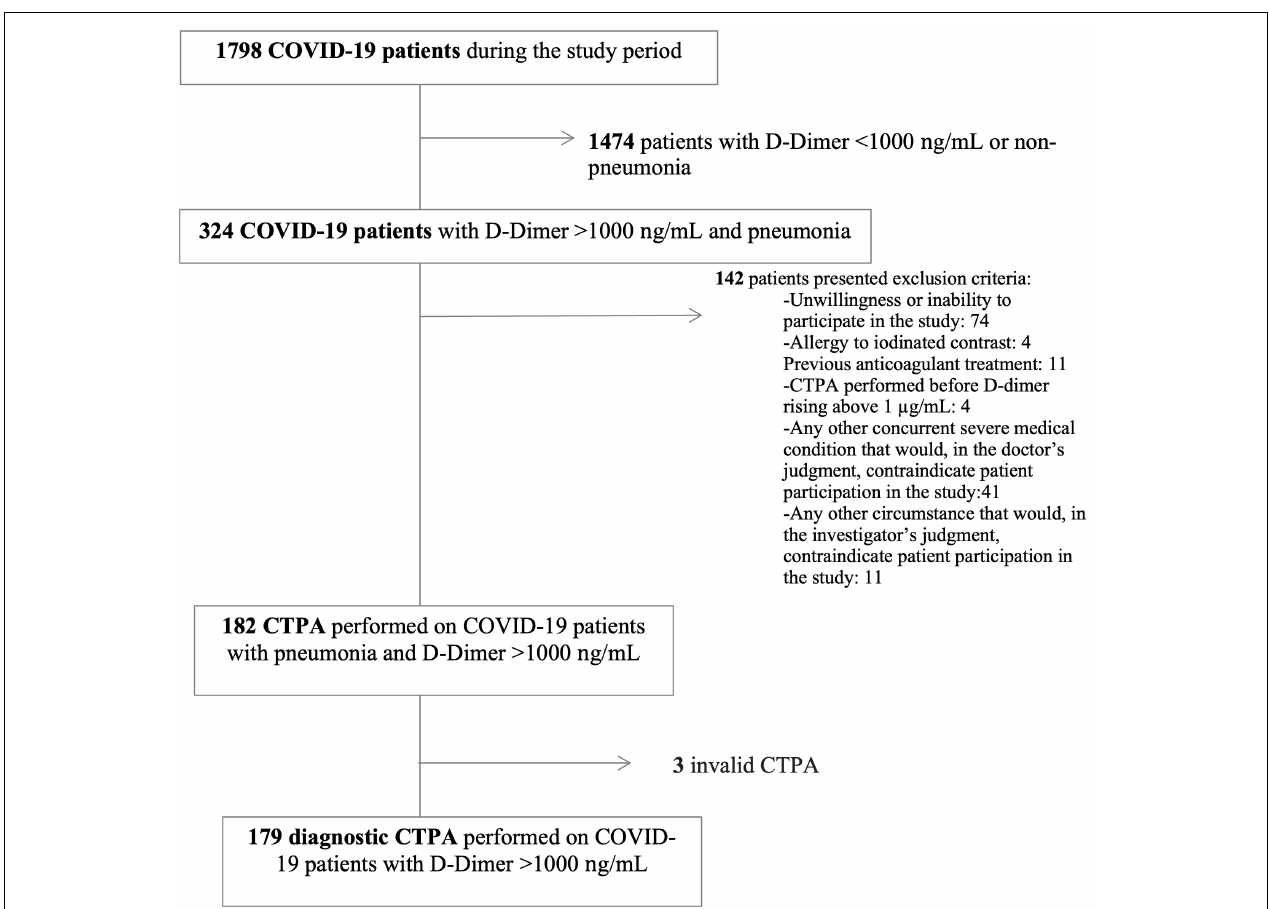
FIGURE 1 | Flow chart. CTPA, computed tomography pulmonary angiography; PE, pulmonary